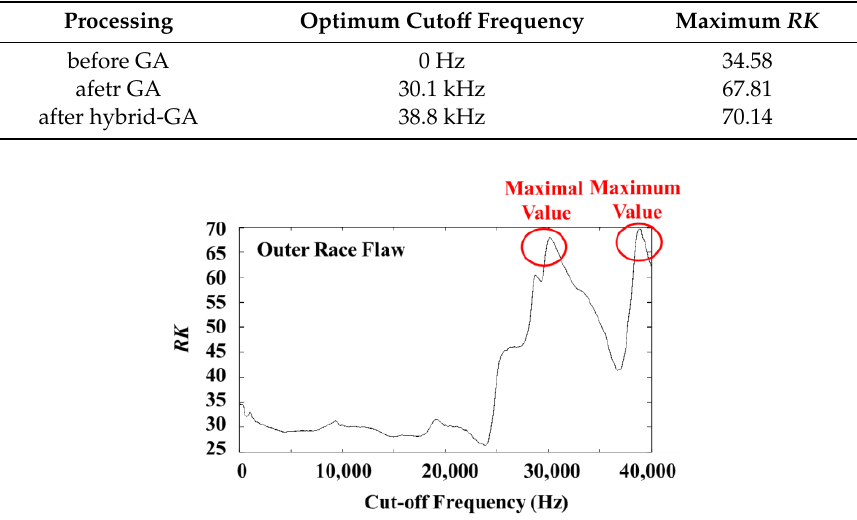
Table 1. Optimum cutoff frequency and kurtosis ratio (RK) of CH3 (learning phase). State of the bearing.